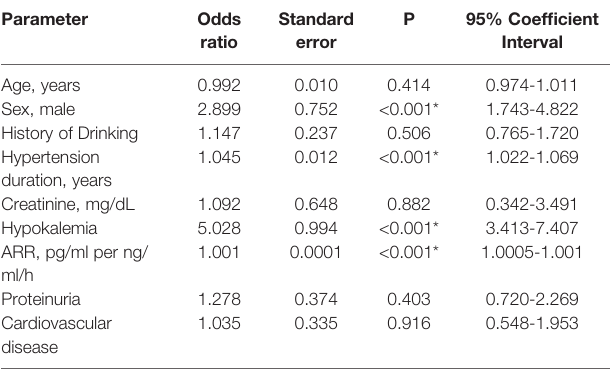
TABLE 2 | Rates of unilateral PA patients without apparent adrenal tumors in each parameter classi fi ed by quartile. Parameter